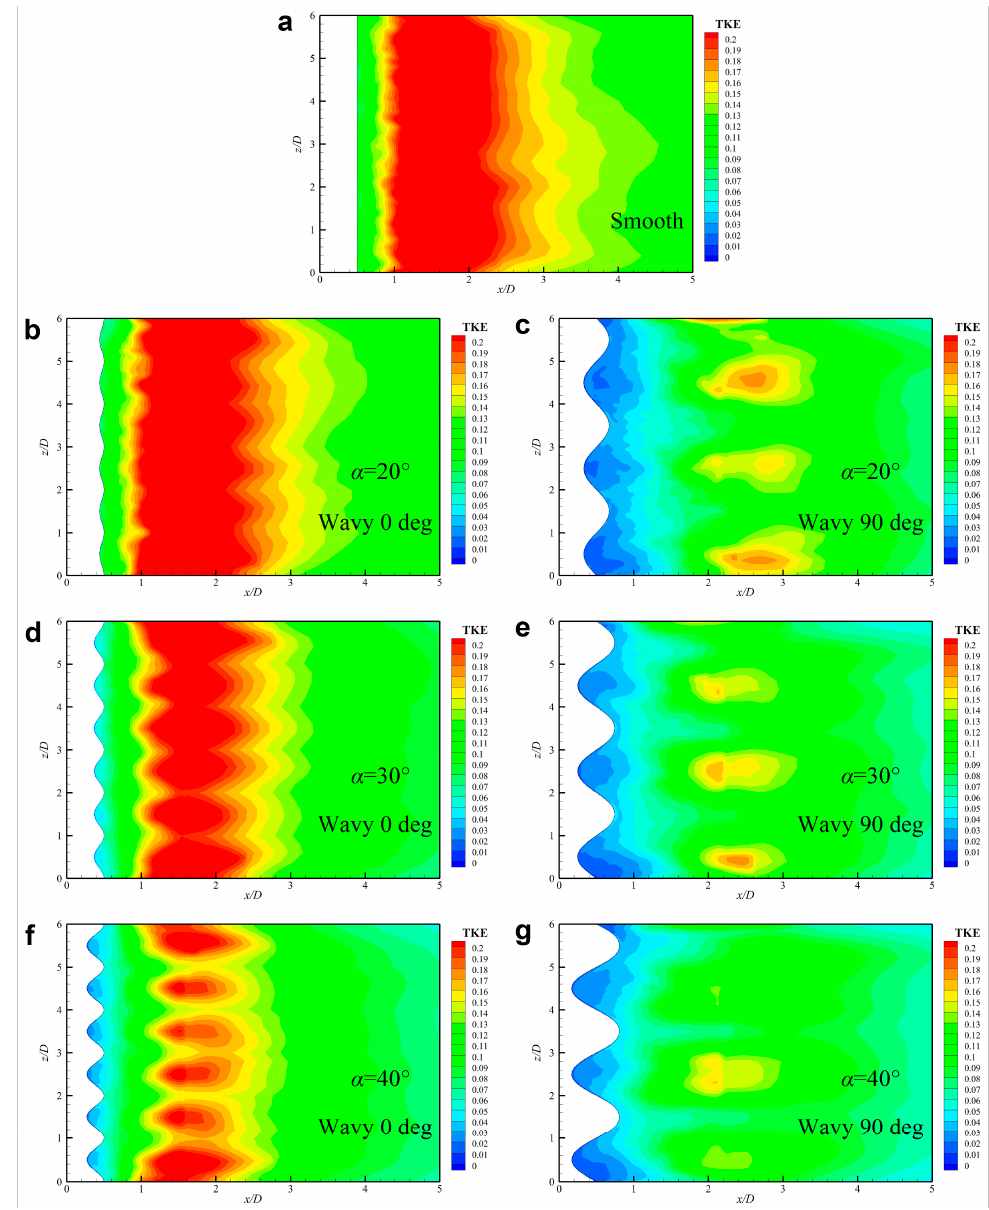
Figure 13. Normalized turbulent kinetic energy (TKE) distributions of ( a ) the smooth cylinder and ( b – g ) three wavy cylinders in the x-z plane.